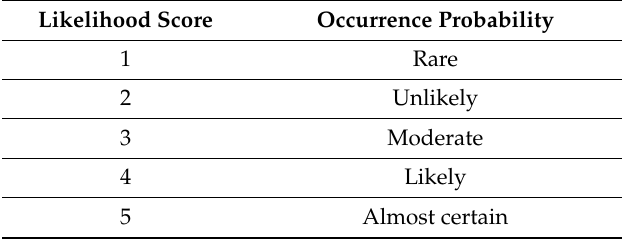
Table 1. Likelihood score (LS) and associated occurrence